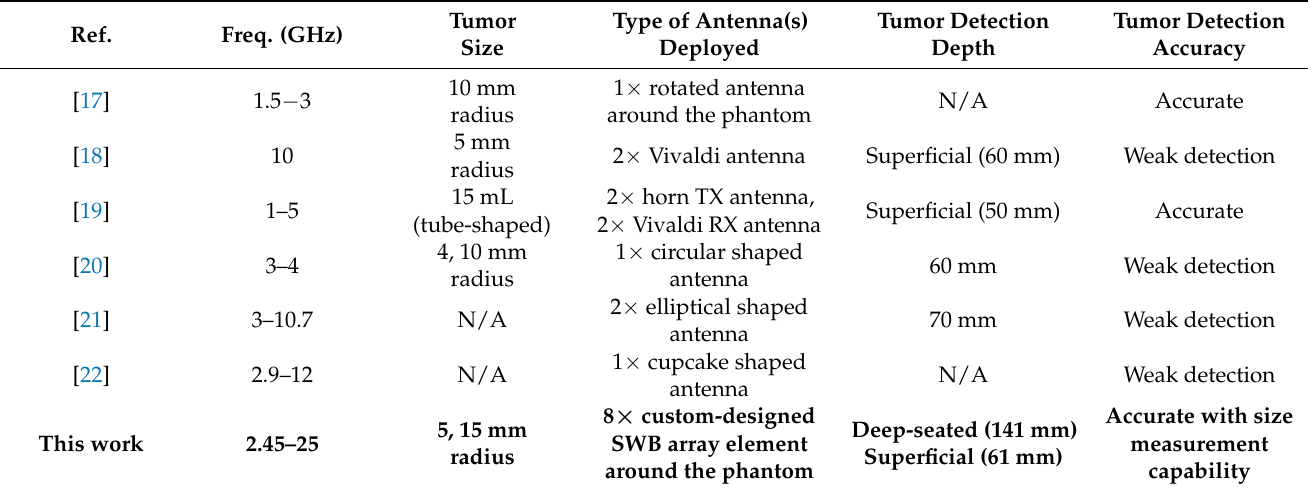
Table 6. Comparison between this work and previous works on microwave reflectometry-based lung tumor